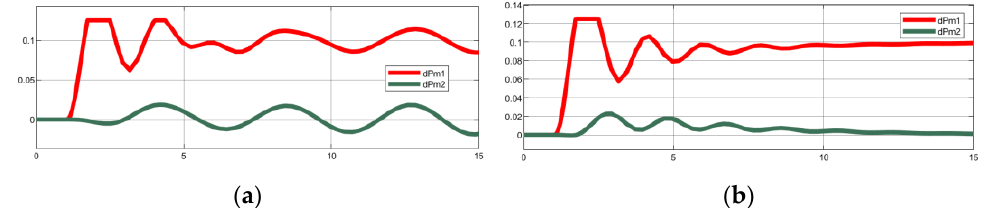
Figure 10. ( a ) Mechanical Power Deviation, Case 1. ( b ) Mechanical Power Deviation, Case 2.